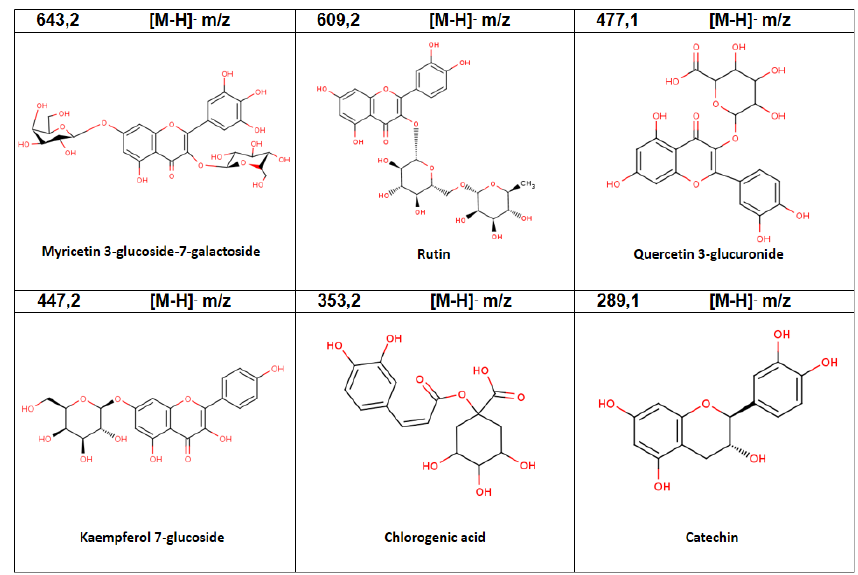
Figure 4. Chemical structures of phenolic compounds identified by LC ‐ MS/MS analysis of aqueous